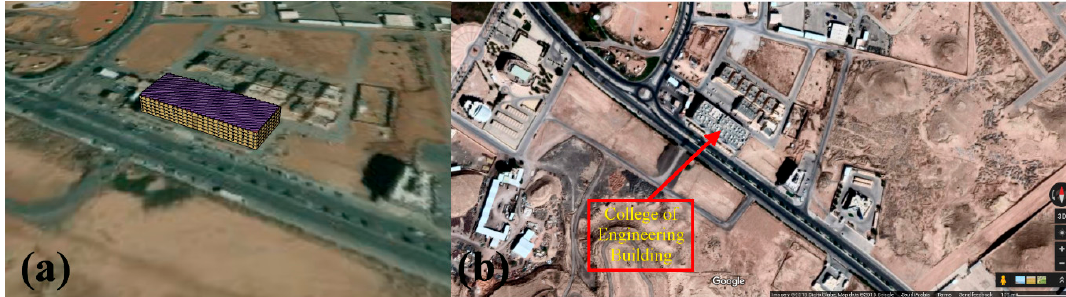
Figure 1. College of Engineering Majmaah ( a ) Model of Building; ( b ) Satellite Image.